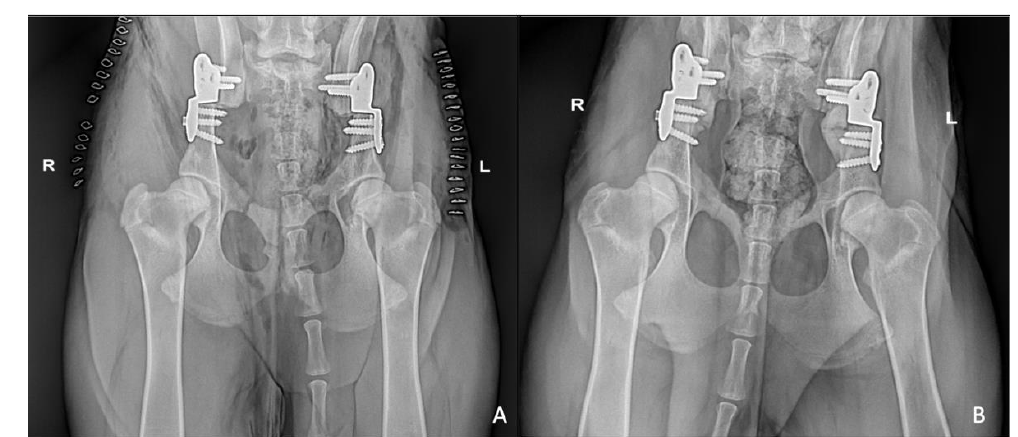
Figure 3. Immediate postoperative ( A ) and 8 weeks post-operative ( B ) VD standard hip radiographs of bilateral single stage DPO: pubic and iliac osteotomies were classified as grade 2.